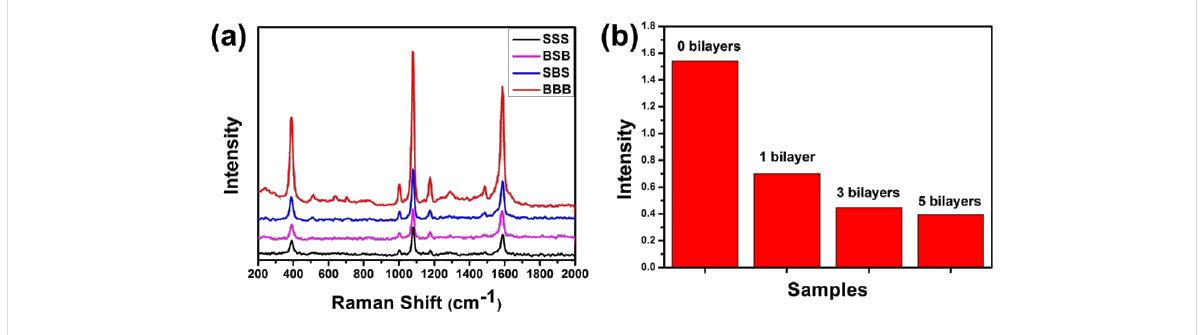
Figure 3: (a) SERS spectra of the sandwich-like multilayer thin films; (b) SERS intensity variations at 1078 cm − 1 for LbL thin films inserted with differ- ent numbers of PDDA/PSS bilayers.